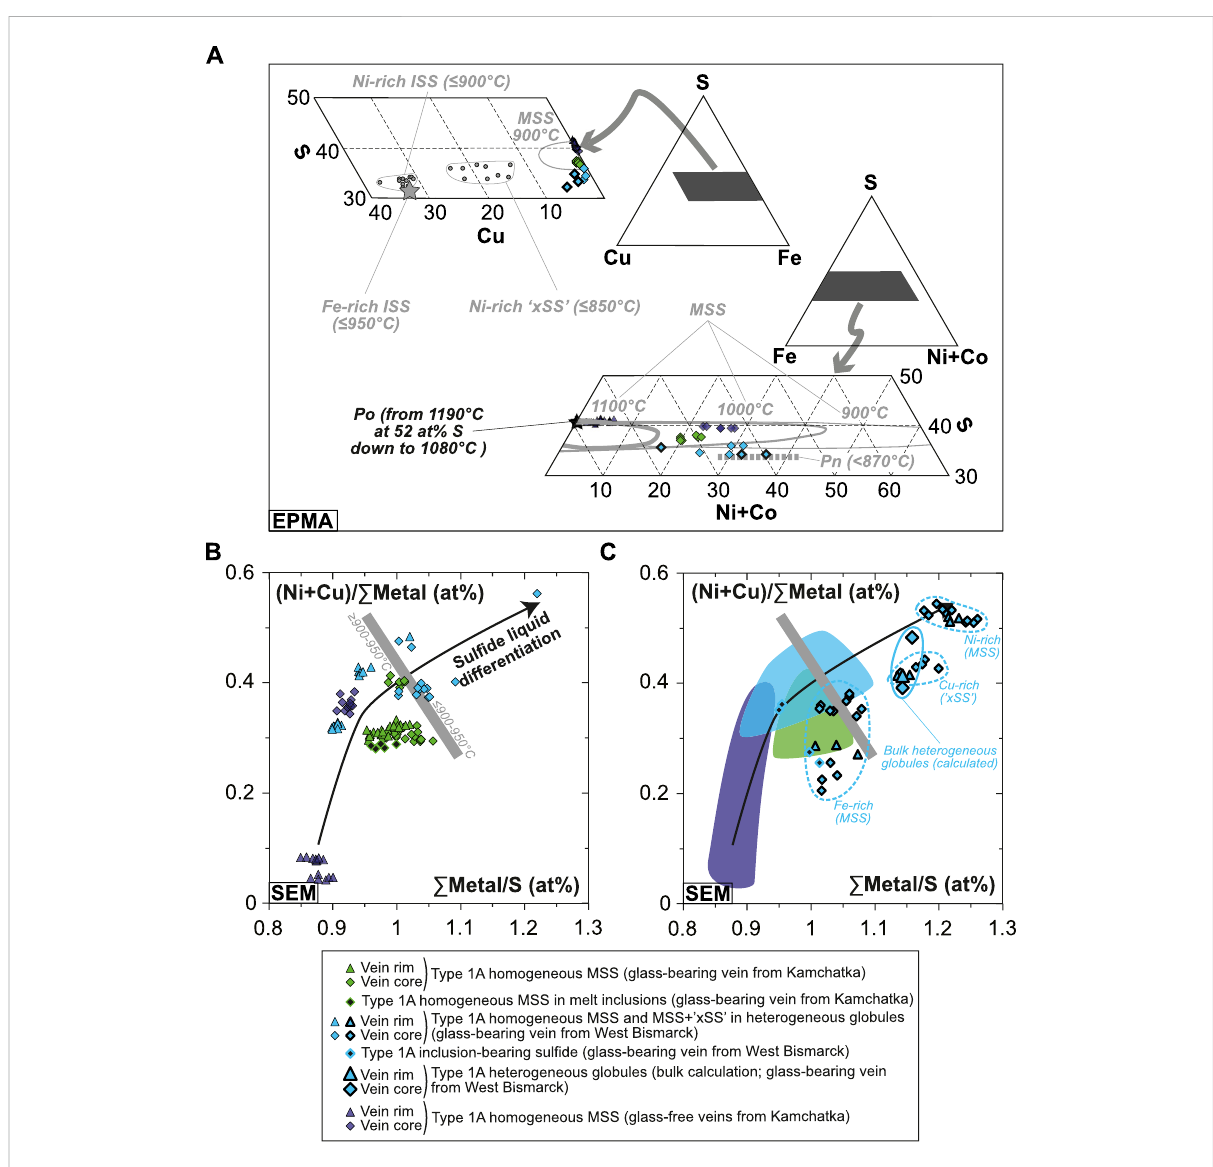
FIGURE 7 Major element abundances in theKamchatka and West Bismarck vein sul fi des. (A) Sul fi de compositions(EPMA) plottedintriangular projections of the Fe(±Ni,Co)-Cu-Ssystem(allinwt%).TheheterogeneousglobulesfromWestBismarckareindicatedusingsymbolswithaboldblackcontour. (B,C) (Ni+Cu)/ (cid:1) Metalplottedagainst (cid:1) Metal/Sfor (B) homogeneousand (C) heterogeneousglobules(SEM;allinat%).Thehomogeneoussul fi dedataareshownwith fi elds in (C) . Literature data for experimental sul fi de phase relations (with stability fi eld temperatures) and compositions in (A) include MSS (solid gray lines; Craig and Kullerud, 1969; Kullerud et al., 1969), pyrrhotite (Po, black star; Fleet, 2006; Mungall, 2007), pentlandite (Pn, dotted gray line; Lorand, 1989; Fleet, 2006; Mungall, 2007), Ni-rich “ xSS ” and ISS (gray dots; Fleet et al., 1993; Fleet and Pan, 1994), and Fe-rich ISS (gray star; Ballhaus et al., 2001). As elsewhere, black symbols stand for literature data in the Fe-S(-O) system, whereas gray symbols stand for literature data in the Fe(±Ni, Co)-S(-O)